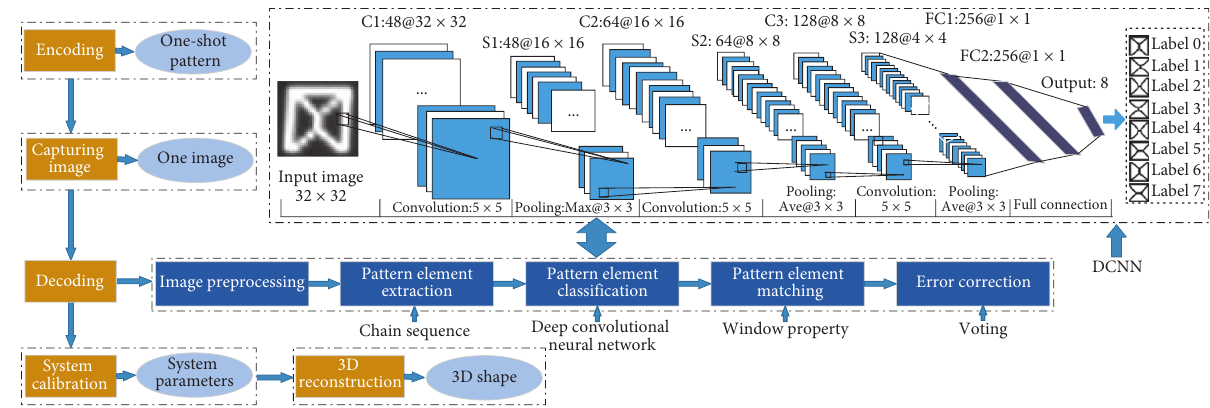
Figure 1: Flowchart showing one-shot 3D reconstruction with